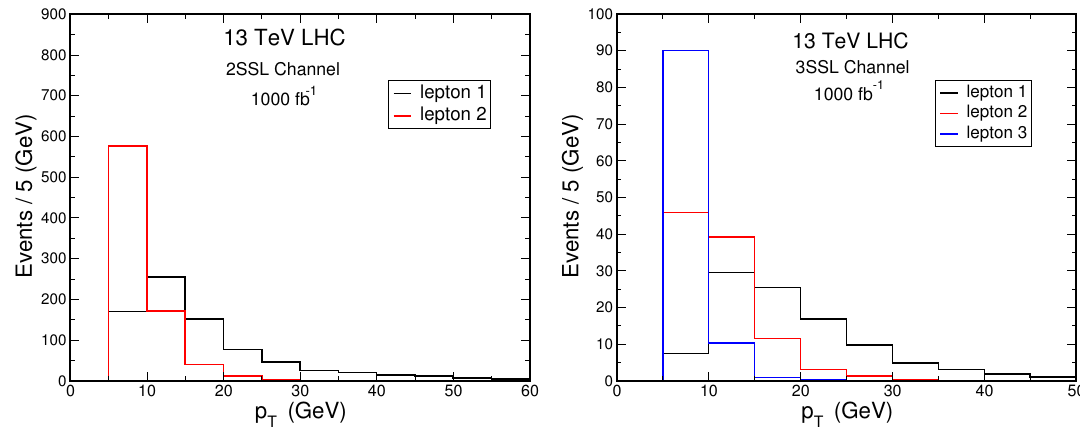
Figure 6 . The left panel shows the distributions of the leading and subleading lepton transverse momentum ( p T ( l )) for signal events in the 2SSL channel at the 13 TeV LHC. The right panel depicts the same in the 3SSL channel. Here leptons are l = e; (cid:22) . In both the panels, the events are weighted at 1000 fb (cid:0) 1